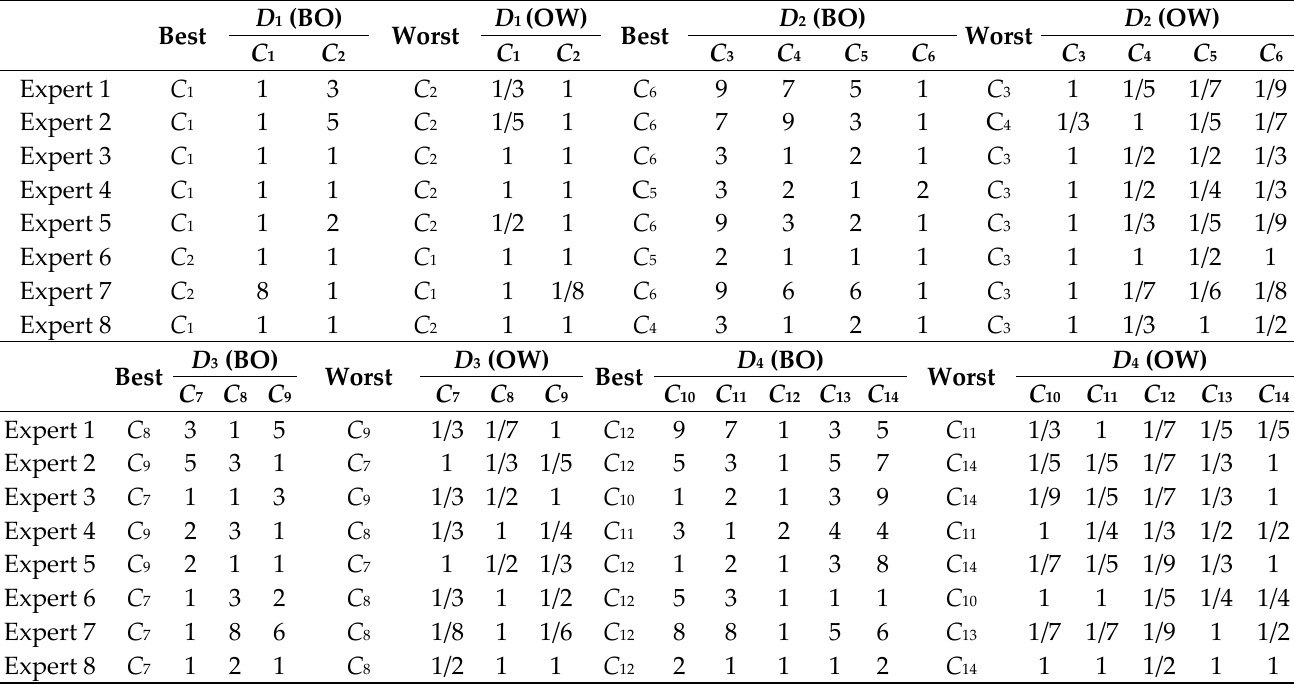
Table 4. BO and OW criteria vectors in the four dimensions.